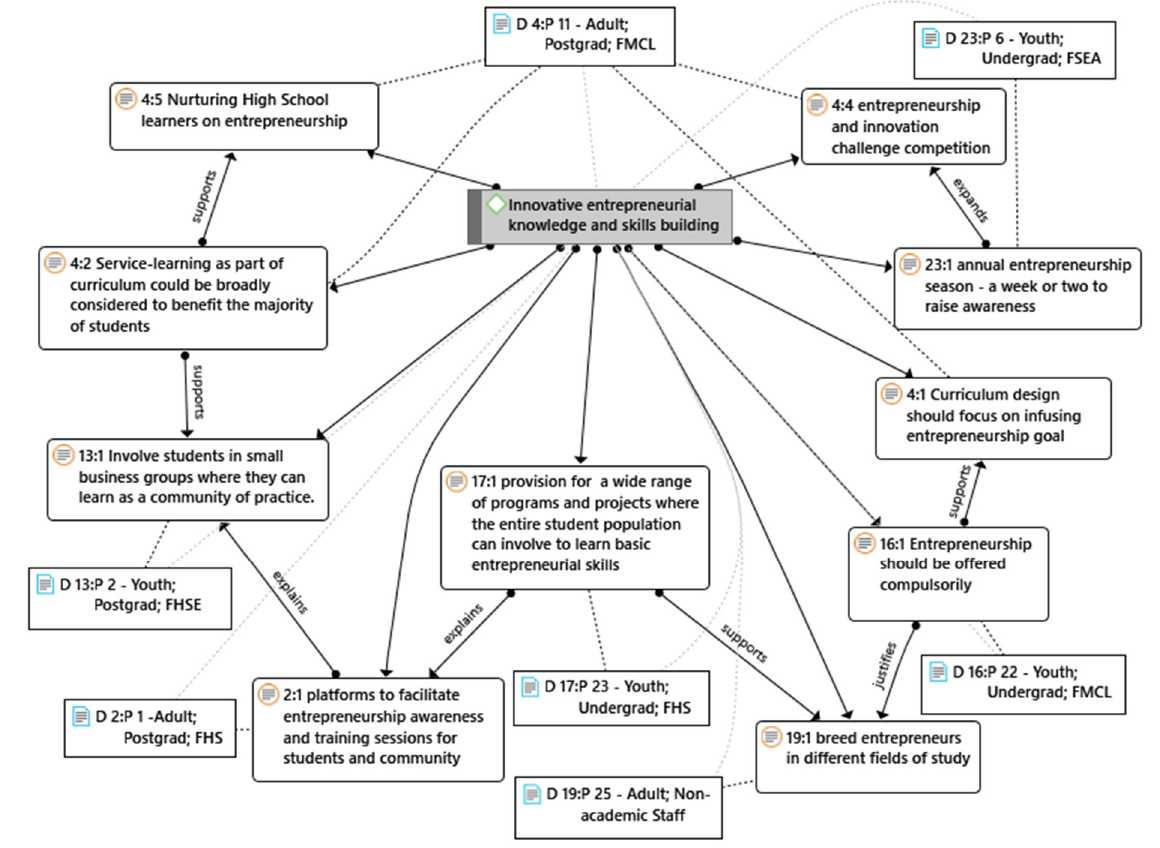
Figure 1. Entrepreneurial knowledge and skill building.